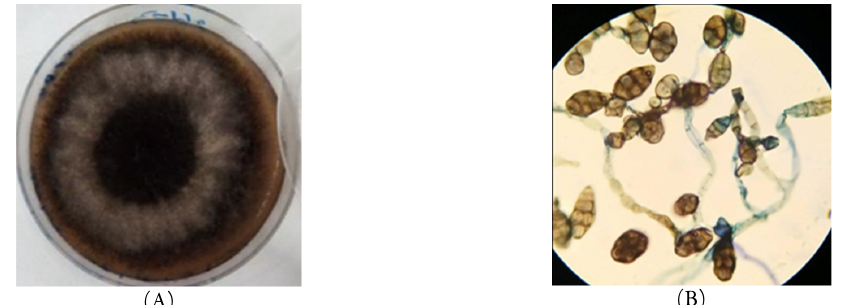
Figure 3. Result of macro and microscopic observation of endophytic isolates ENd, ENf, and ENg; (A) macroscopic characterization; (B)microscopic